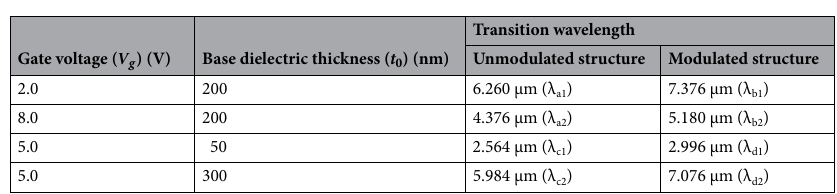
Table 1. Transition wavelengths from elliptic to type II hyperbolic dispersion based on plots shown in Fig. 3.